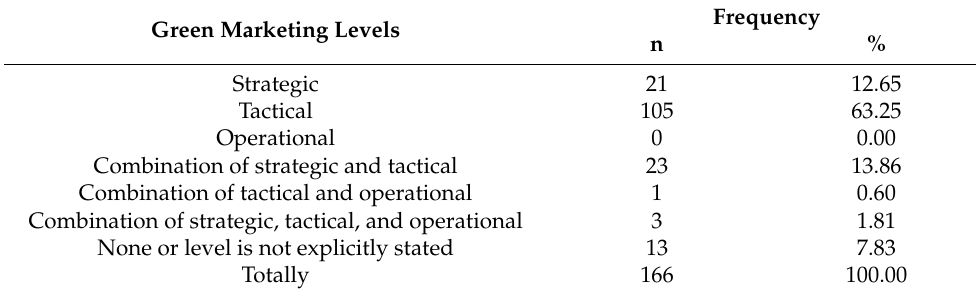
Table 4. The distribution of research across green marketing levels.